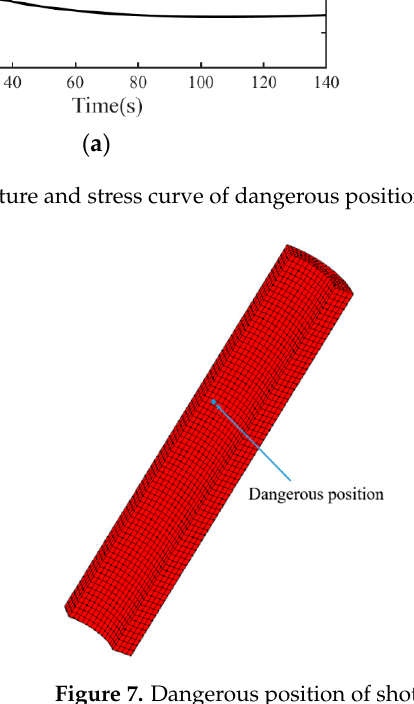
Figure 7. Dangerous position of shot sleeve.